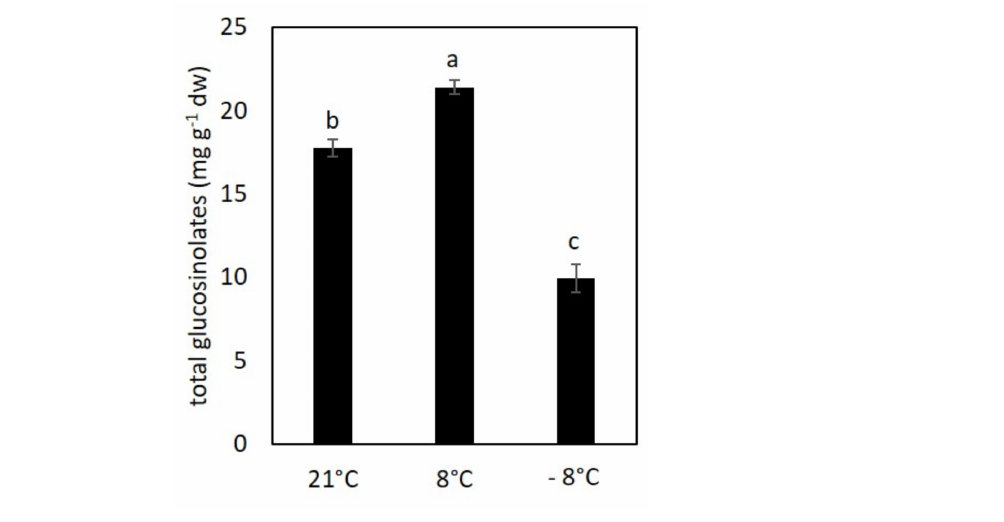
Figure 6. The content of total glucosinolates in kale exposed to low temperatures. Value marked with different letters are significantly different at p <